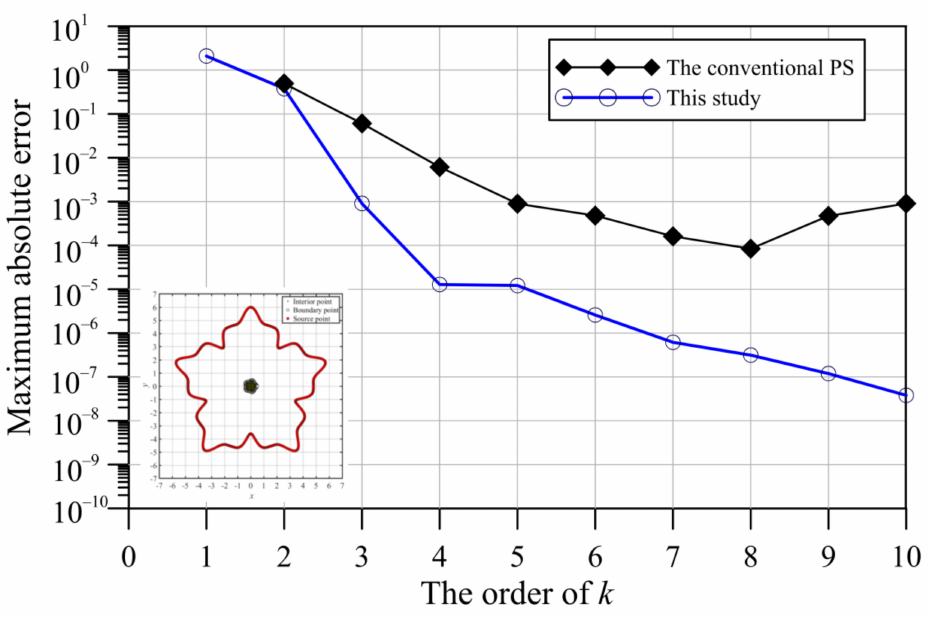
Figure 19. The computed MAE values of the original PS and the proposed method.